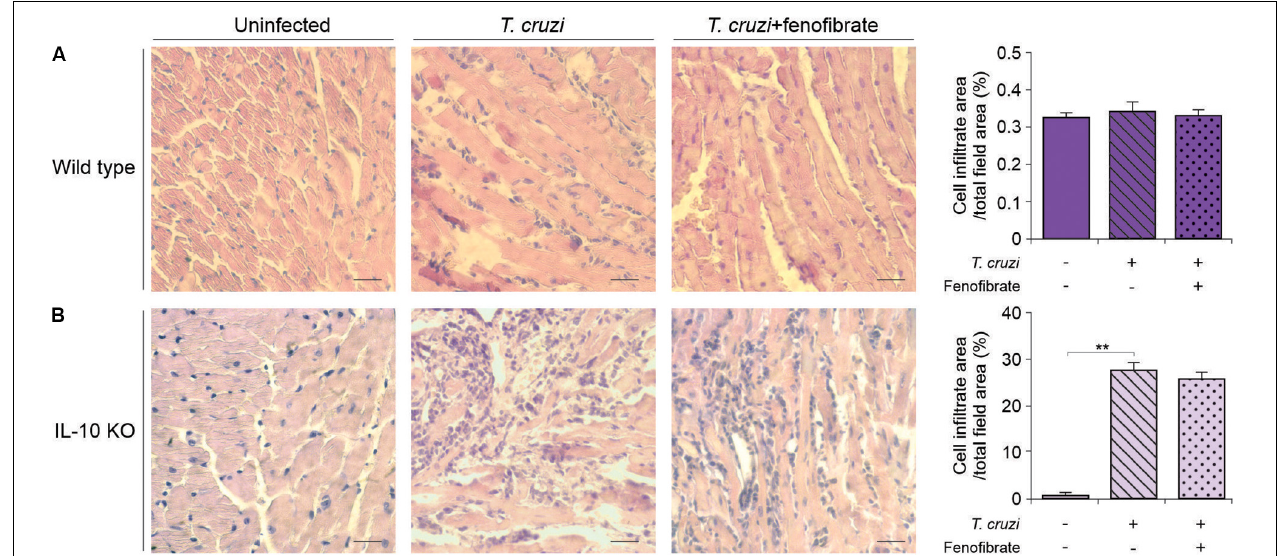
FIGURE 4 | Inflammatory reaction in the heart. Histological sections of the heart of uninfected (left panel), T. cruzi- infected (center panel), and T. cruzi- infected fenofibrate-treated (right panel), WT (A) and IL-10 KO (B) mice. Bar graphs: infiltrate score quantification. Differences between groups were analyzed by ANOVA (mean ± SEM) followed by Tukey post hoc test. 7 mice per group, 3 replicate experiments. ** p < 0.01.